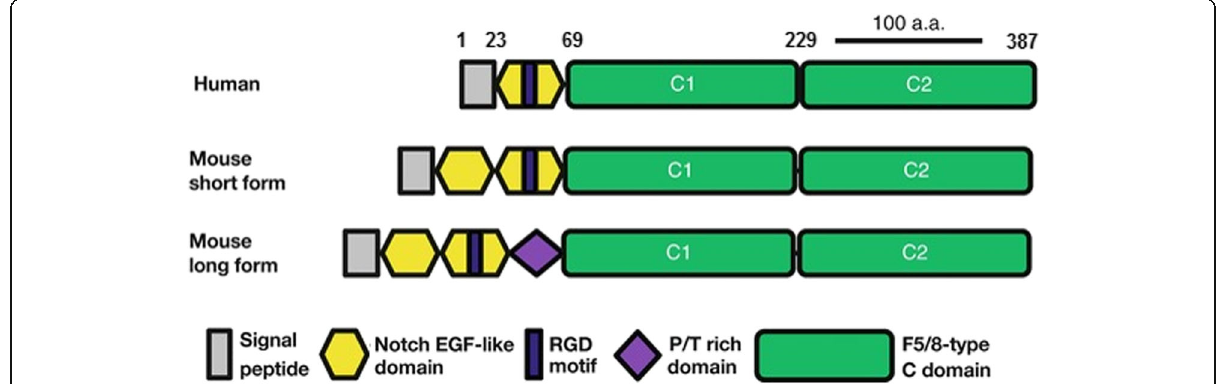
Fig. 1 Comparison of molecular structure and functional domains between human MFG-E8 and the long and short forms of mouse MFG-E8 (modified from ( Oshima et al. 2014